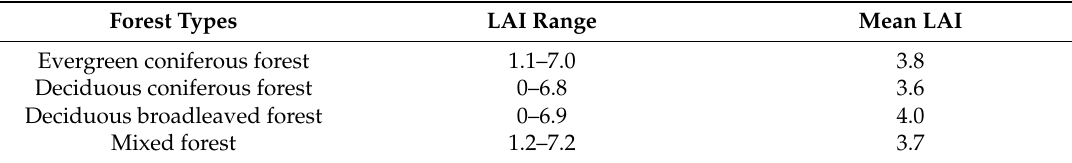
Table 5. LAI estimation of four forest types.